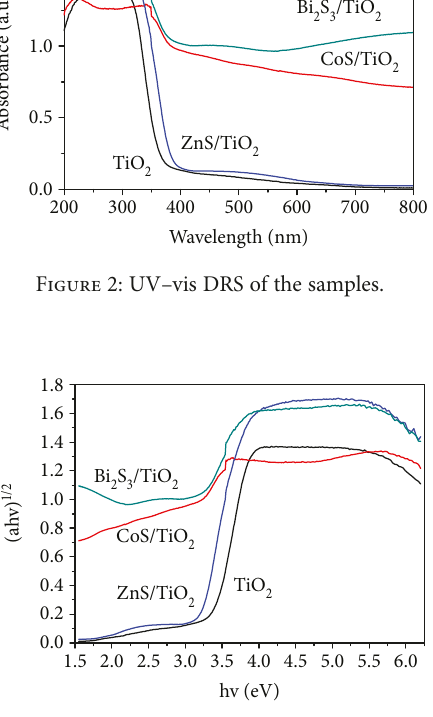
Figure 3: Plots of ( ahv ) 1/2 vs (hv) for estimating optical band gaps of the